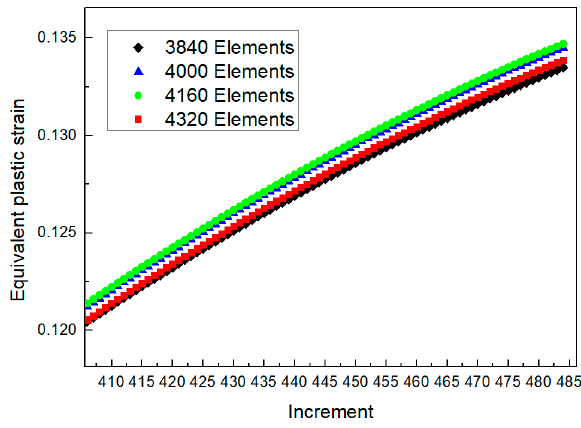
Figure 10. Analysis of grid sensitivity.